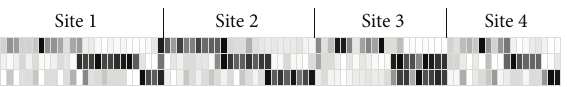
Figure 6: Item memberships of each cluster in heterogeneous partition case.